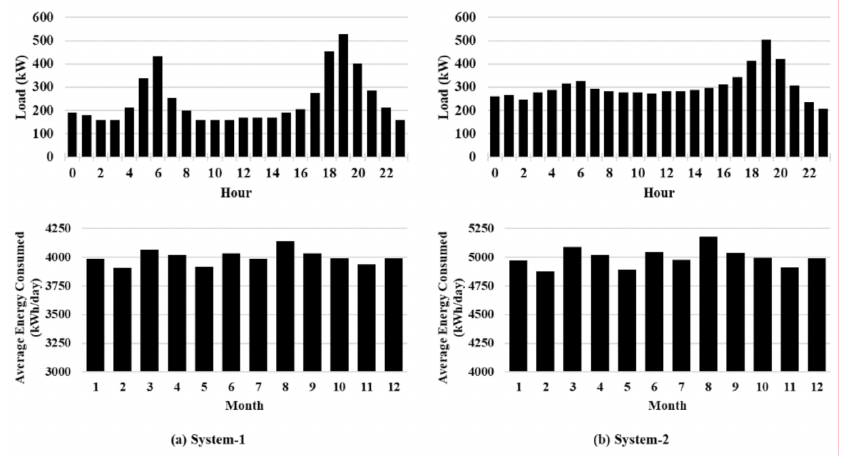
Figure 9. Load profiles of System-1 and System-2. The deviation between peak load and the hourly average load in System-1 was greater than in System-2.